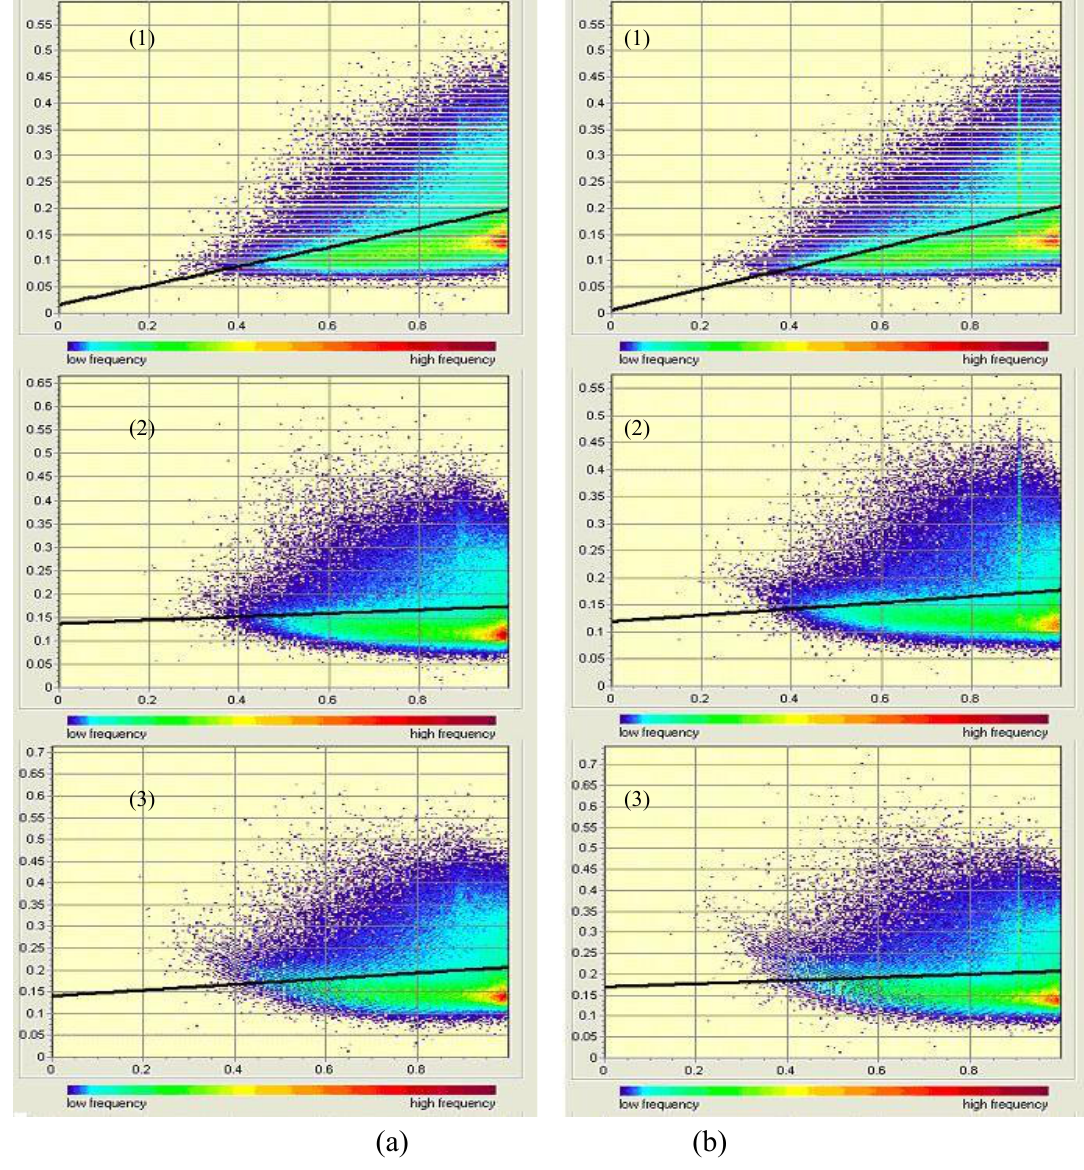
Figure 4. S scatter plots and the linear regression fitting lines of reflectance ρ versus cosi for ETM+ band 1 before and after correction: (a) based on 90 m SRTM DEM; (b) based on DEM constructed from 1:50,000 scale topographic map; (1) before topographic correction; (2) SCS correction; (3) Minnaert